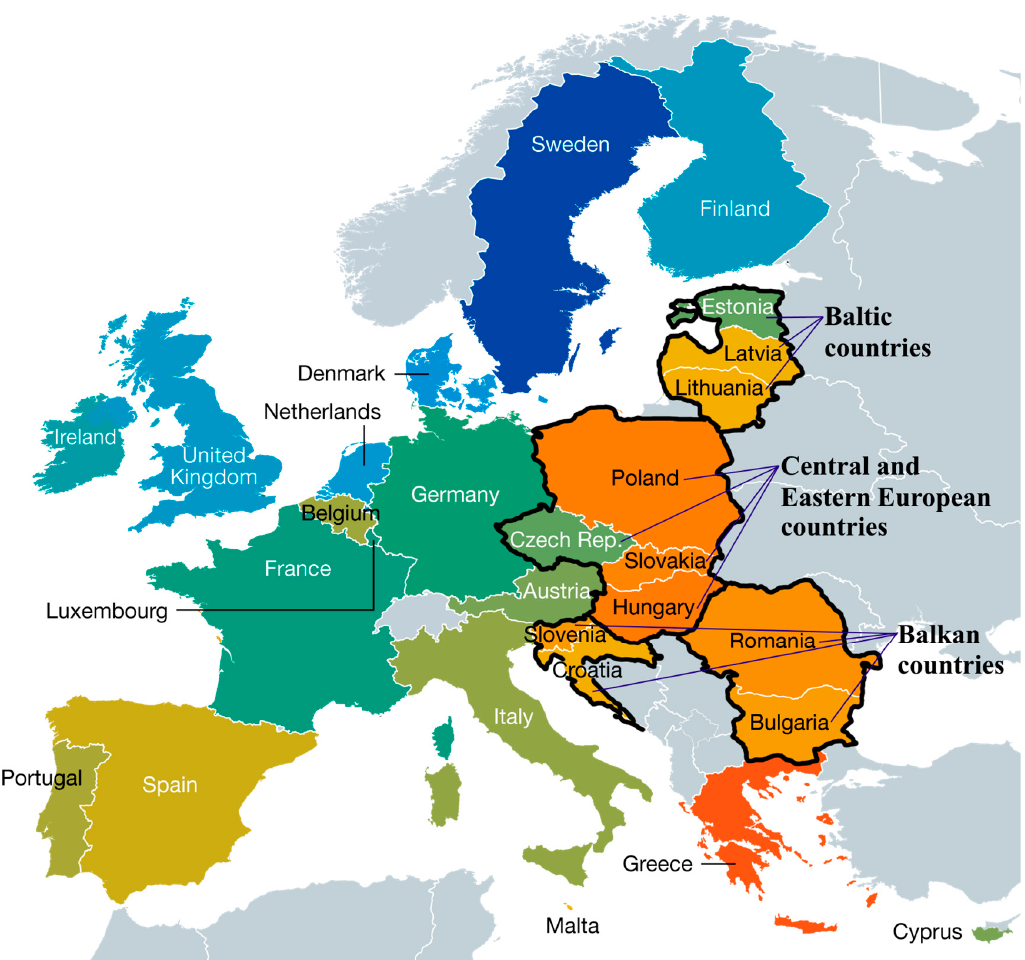
Figure 1. Map of the study area with defined regional blocks and relating European Union Member States.